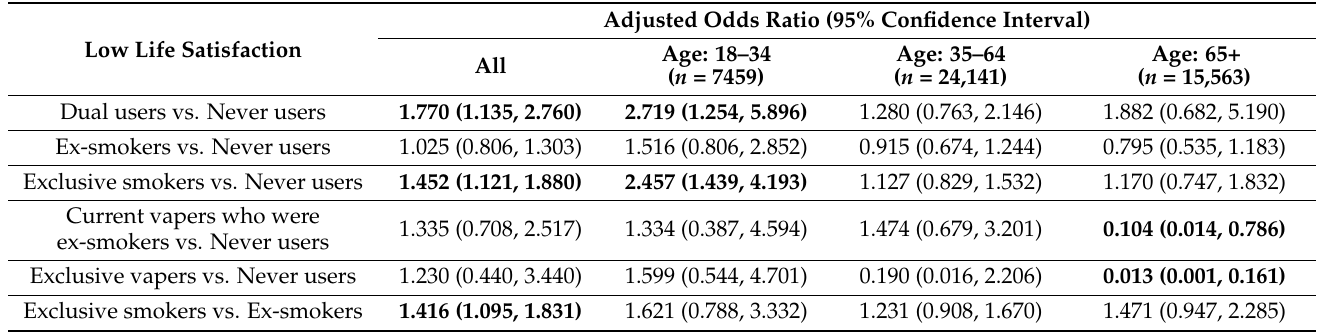
Table 2. Association of life satisfaction with smoking/vaping